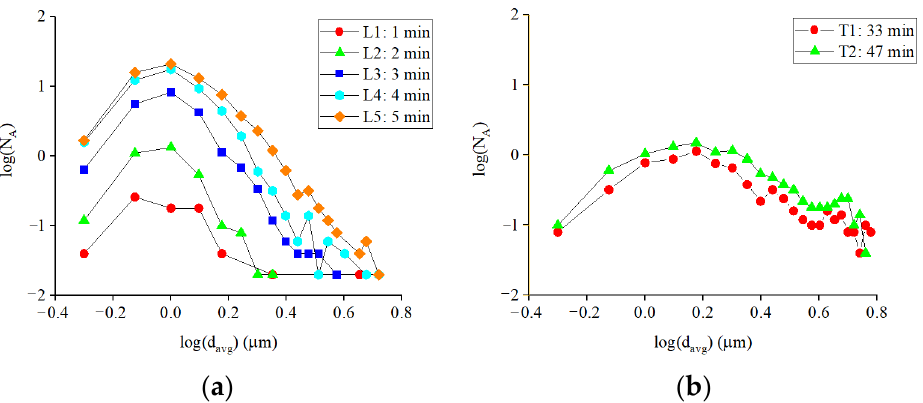
Figure 8. The evolution of particle size distribution for CaS type inclusions in Heat 1 including inclusions with d max > 0.5 μ m ( a ) ladle samples and ( b ) tundish samples.